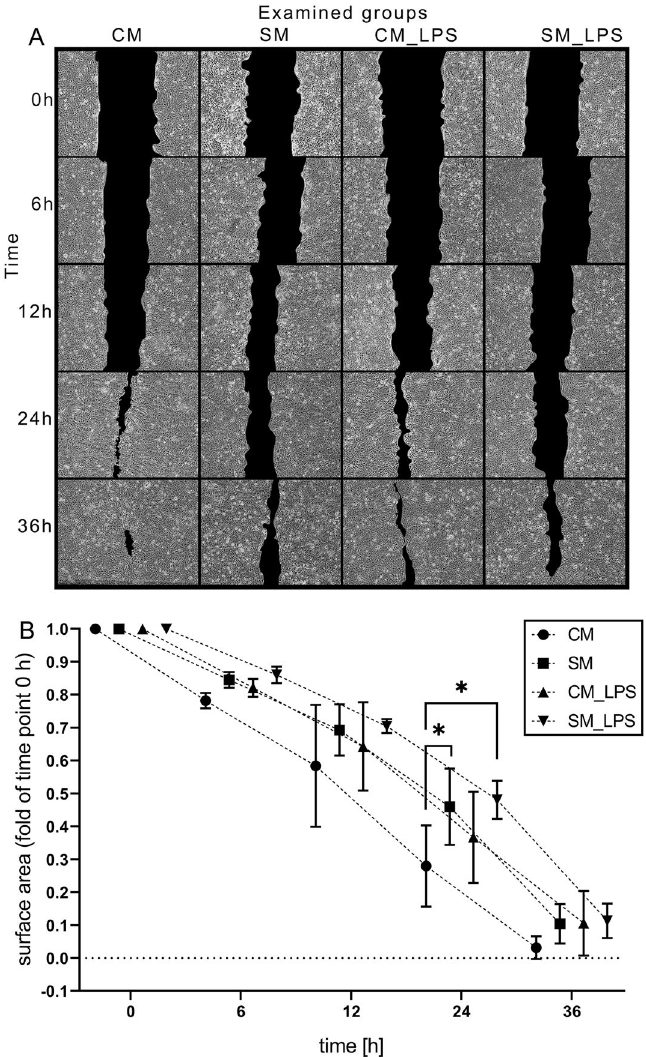
Figure 3. ( A ) Scratch assay of LESC monolayer in response to conditioned medium from ADSC (CM) in standard condition and in induced inflammation (LPS groups). The results present a one selected microscopic image from six replications of each group (CM, SM, CM_LPS, SM_LPS) at time points (0 h, 6 h, 12 h, 24 h, 36 h). Scratch area marked with black. ( B ) Scratch surface area as fold of time point 0 h of examined groups (CM, SM, CM_LPS, SM_LPS) in time (6 h, 12 h, 24 h, 36 h). Two-way ANOVA test, *p <